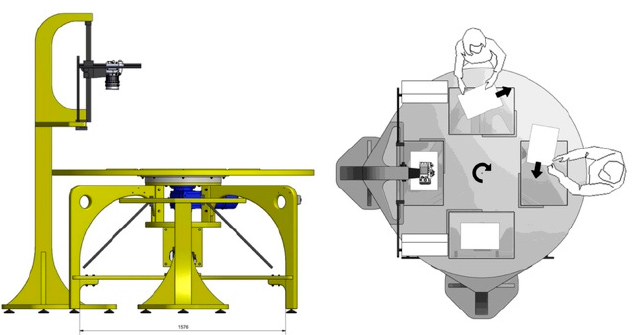
Figure 3. Left: Technical drawing of Recto/Verso scanner; Right: Birds-eye view of the Scheme 1. documents per day on average. The presence of two people, both close together, ensured better social interaction of the team, improving the quality of work that risked deteriorating due to the repetitive aspect of the operation. The design of the scanner and the components were put in open source by Factum Arte. The scanner, after quality control, obtained the European ‘ISO’ safety certification. The whole system was designed to make it replicable for other institutions wishing to maximise their digitisation experience by reducing costs and maintaining a high level of technical performance, without being forced to choose between companies currently on the digitisation market. Image taken with the kind permission of Factum Arte